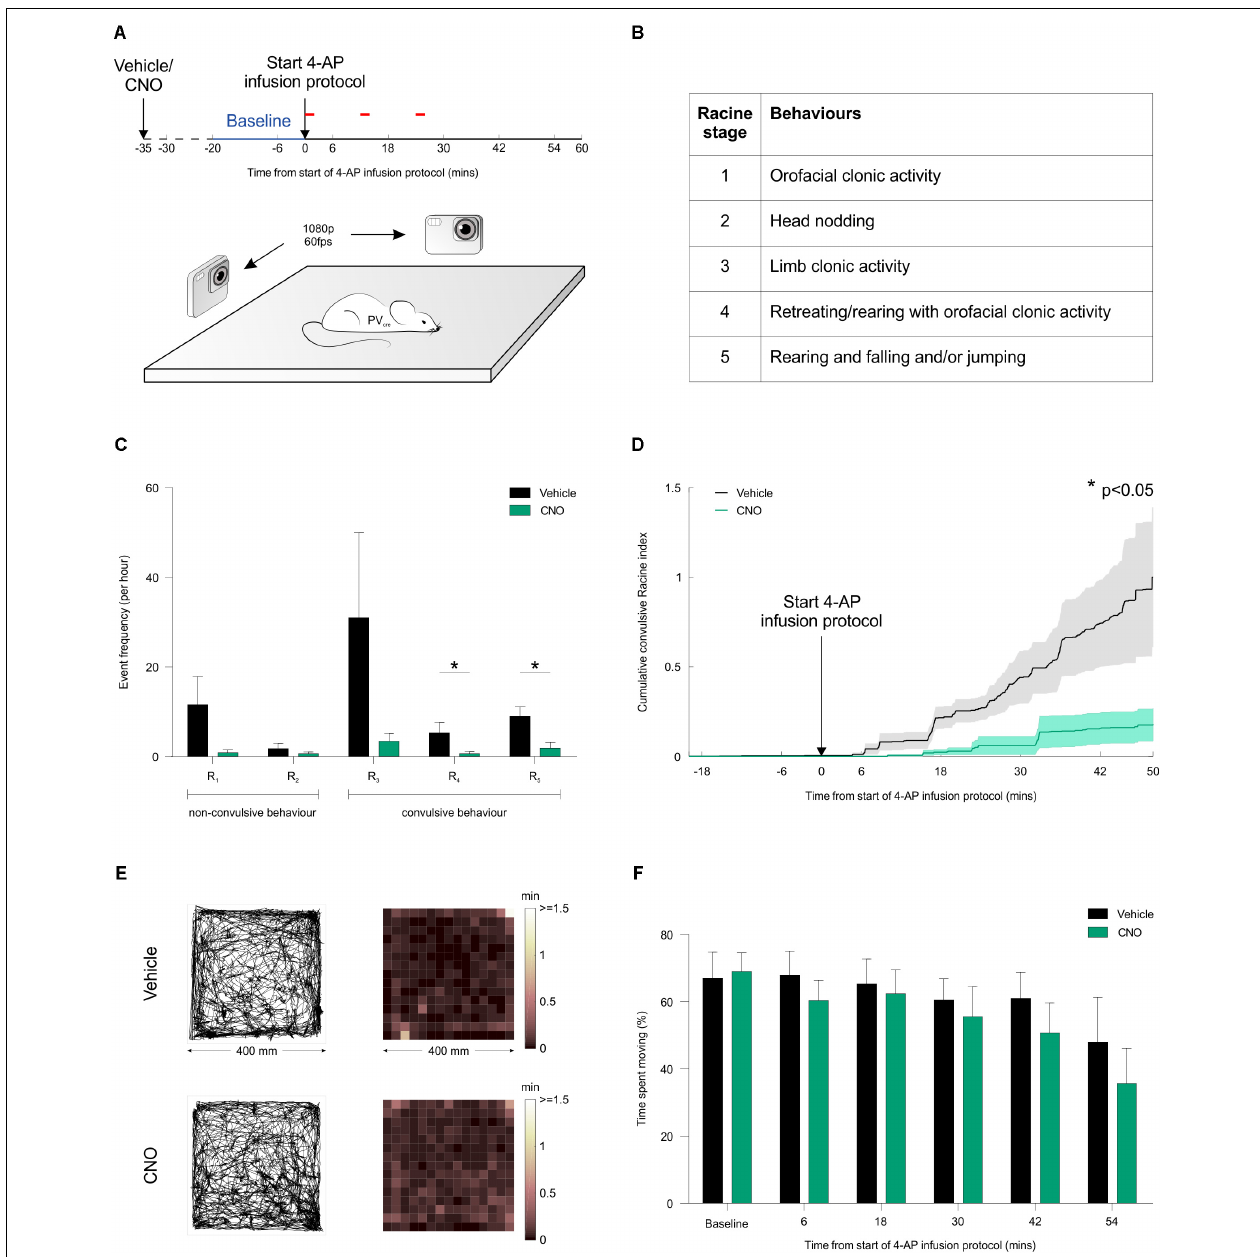
FIGURE 7 | Chemogenetic recruitment of hippocampal PV interneurons suppresses convulsive behaviors in vivo . (A) Cartoon showing experimental design for assessing seizure activity in animals expressing the hM 3 D q receptor in hippocampal PV interneurons. Fifteen minutes before behavioral monitoring, each animal received an i.p. injection of either vehicle control or CNO. Baseline behavior was then monitored for 20 min (blue period), after which the intra-hippocampal 4-AP infusion protocol was started and monitoring continued for a period of 60 min (red bars indicate the timing of each infusion). Behavior was recorded by two high-speed, high-definition cameras oriented at right angles to one another, while a third camera tracked the animal from above. (B) Table describing the Racine scale used to score the animal’s seizure behavior from video analysis offline. (C) There was a general tendency for seizure behaviors to be suppressed by CNO across the Racine categories. The frequency of Racine 4 and 5 convulsive events was significantly reduced when CNO was administered compared to vehicle [ N = 12 vehicle and 10 CNO experiments; Racine 1: U ( 12 , 10 ) = 34, p = 0.0571; Racine 2: U ( 12 , 10 ) = 59.5, p > 0.9999; Racine 3: U ( 12 , 10 ) = 37, p = 0.1335; Racine 4: U ( 12 , 10 ) = 31, p = 0.0372; Racine 5: U ( 12 , 10 ) = 24.5, p = 0.0127, two-tailed Mann–Whitney tests]. (D) Convulsive behavior, plotted as a normalized cumulative score was significantly lower following administration of CNO compared to vehicle [ N = 12 vehicle and 10 CNO experiments, U ( 12 , 10 ) = 29.5, p = 0.0411, two-tailed Mann–Whitney test]. (E) For mice expressing the hM 3 D q receptor in hippocampal PV interneurons, plots illustrate tracking data and corresponding spatial distribution of time spent across the behavioral arena (400 mm by 400 mm). Representative data are shown for an animal receiving an i.p. injection of vehicle (top) or CNO (bottom). In each case, data is shown for a 20-min period following the start of the 4-AP infusion protocol. (F) There was no difference between the vehicle and CNO groups in terms of the percentage of time spent moving [ N = 10 vehicle and 11 CNO experiments, treatment: F ( 1 , 104 ) = 1.686, p = 0.197, two-way ANOVA].